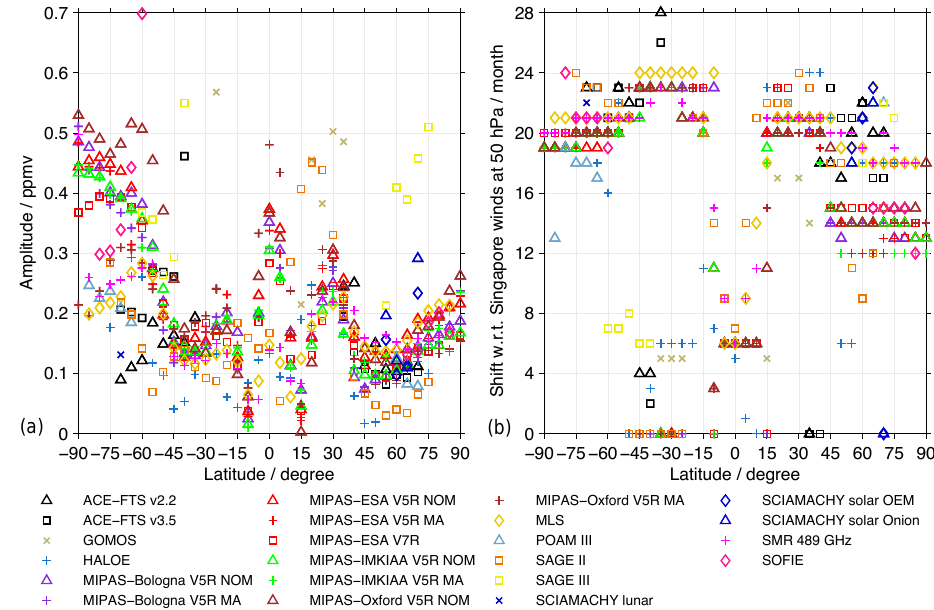
Figure 13. The latitude distribution of the QBO variation at a pressure level of 7.5hPa.